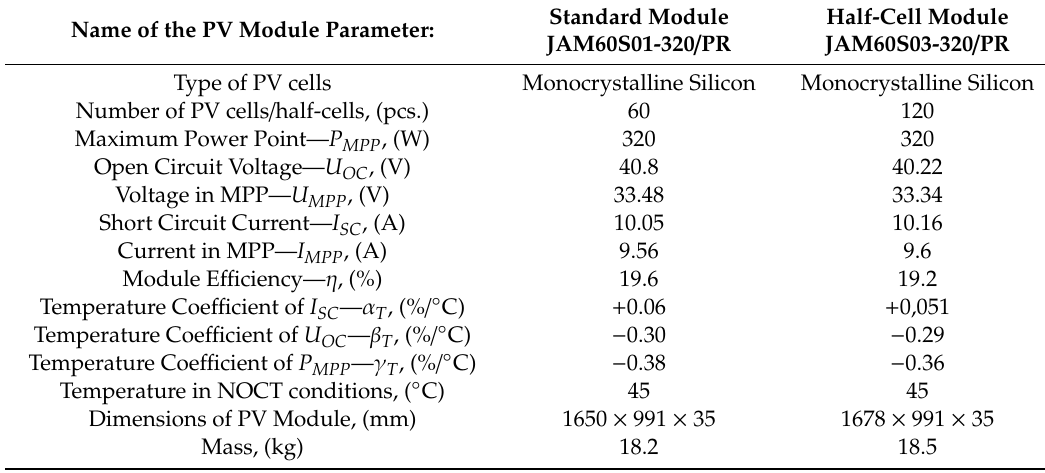
Table 1. Comparison of parameters of PV modules: standard and half-cell, provided by the manufacturer—in STC. Author’s elaboration based on producer data